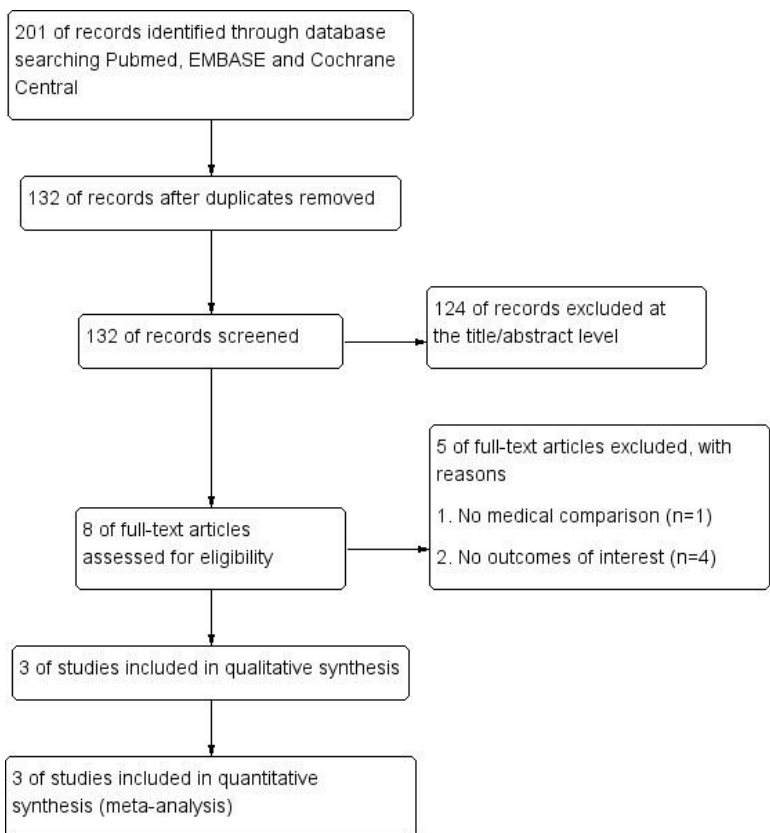
Figure 1. Flow chart of literature search and study selection.